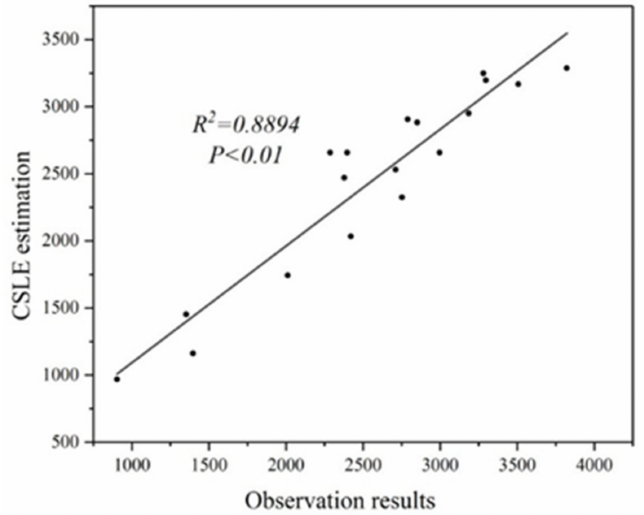
Figure 2. Comparison of soil erosion modules between the CSLE estimation and observation results from published papers on research in the TGRA.